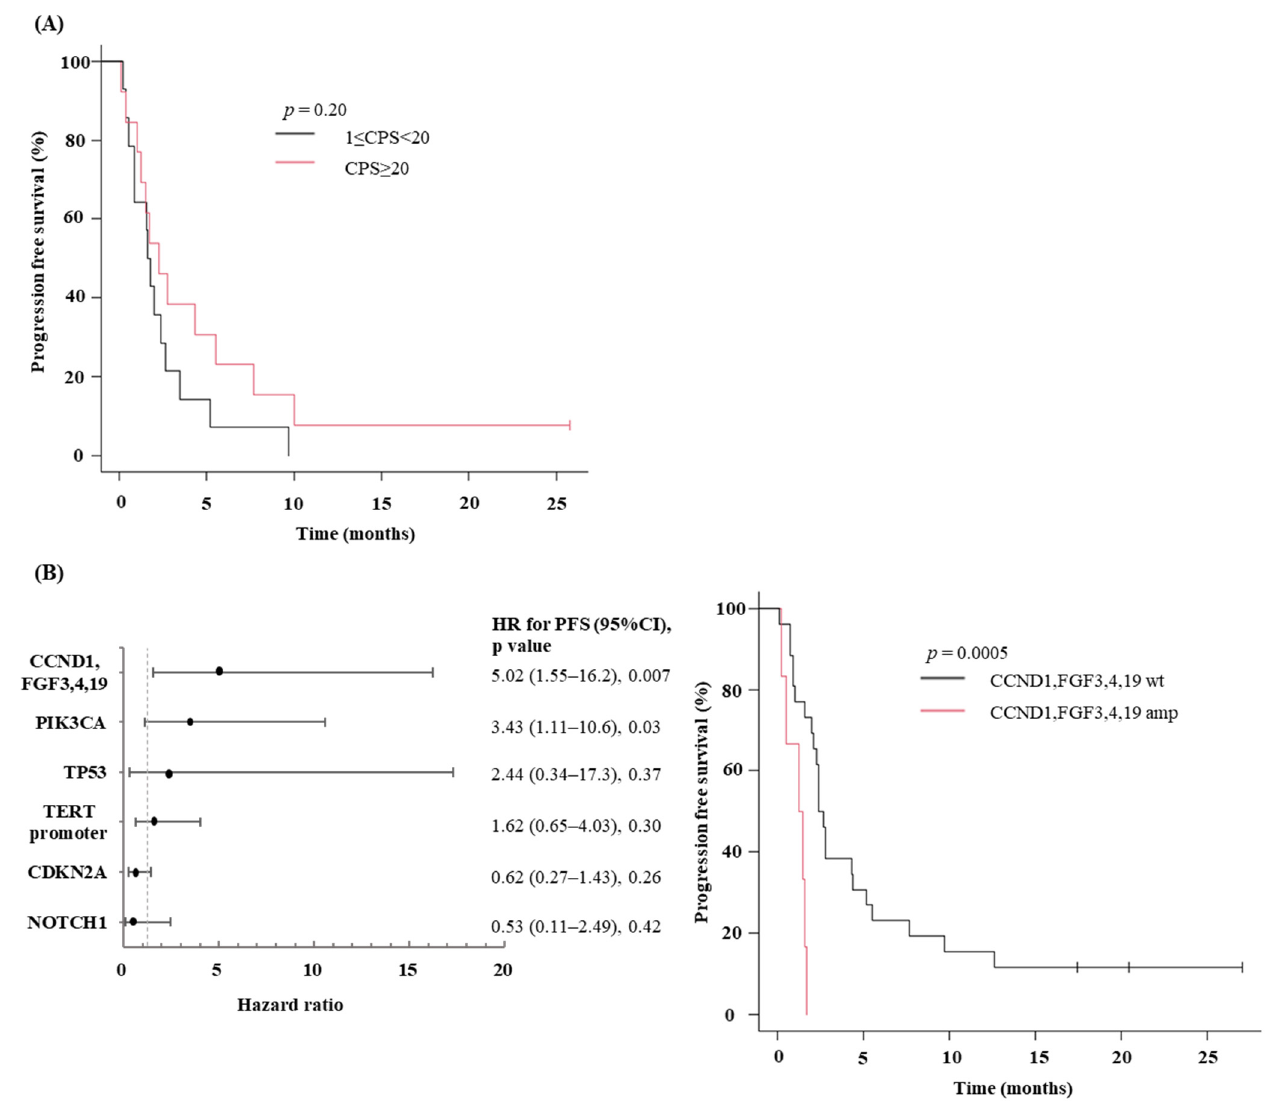
Figure 4. Outcomes of ICI therapy and association between other factors. ( A ) The Kaplan–Meier curves for progression-free survival by PD-L1 CPS value among R/M HNSCC patients who have received ICI monotherapy to date in our department. We analyzed 27 patients with measured PD L1 CPS. ( B ) Outcomes based on genetic alteration. Forest plots showing hazard ratios (HRs) with 95% CIs for progression-free survival (PFS). Kaplan–Meier curves for PFS in patients with CCND1 and FGF3, 4, 19 amplification or wild type group. Of the 34 R/M HNSCC patients in this study, 32 were analyzed, excluding one who received chemotherapy with ICI and one who could not be evaluated due to interruption of the first round of treatment. p -values are according to the log-rank test. HR, hazard ratio; amp, amplification; wt, wild-type.